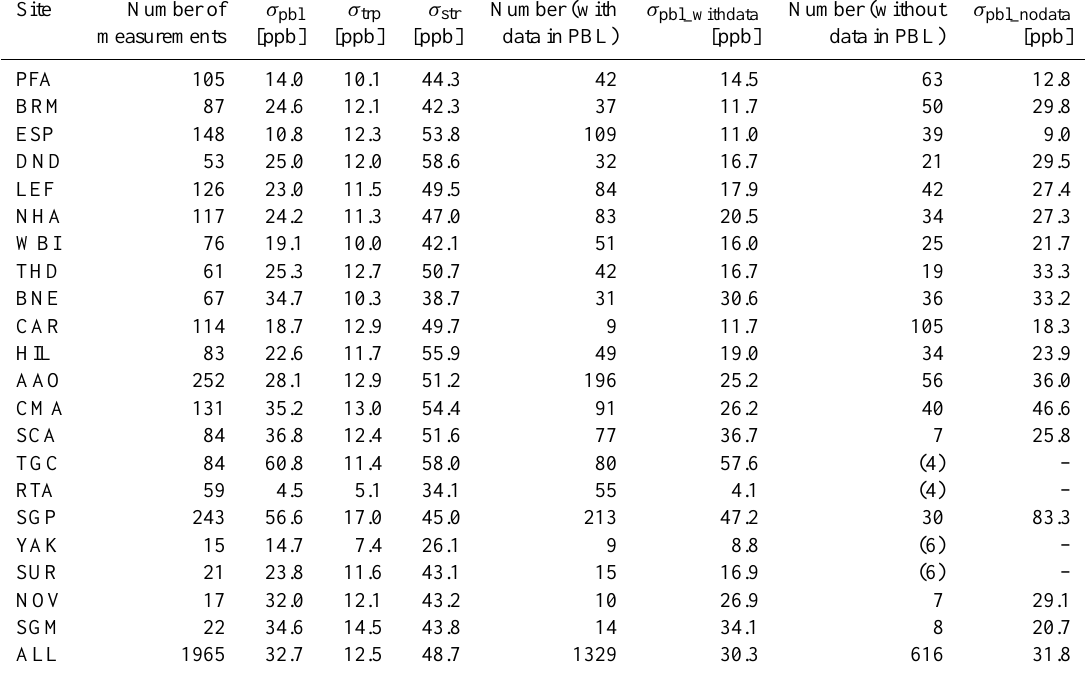
Table 2. Uncertainties of partial XCH 4 at each aircraft observation site for domain I, below the planetary layer (PBL) ( σ pbl ) ; II, from the PBL to the tropopause ( σ trp ) ; and III, above the tropopause ( σ str ) . In addition, σ pbl when there were aircraft data for the PBL and when there were no aircraft data for the PBL ( σ pbl_withdata and σ pbl_nodata ) were also evaluated separately. The numbers shown in parentheses indicate that the number of measurements used to determine σ pbl_nodata was less than seven. See text for